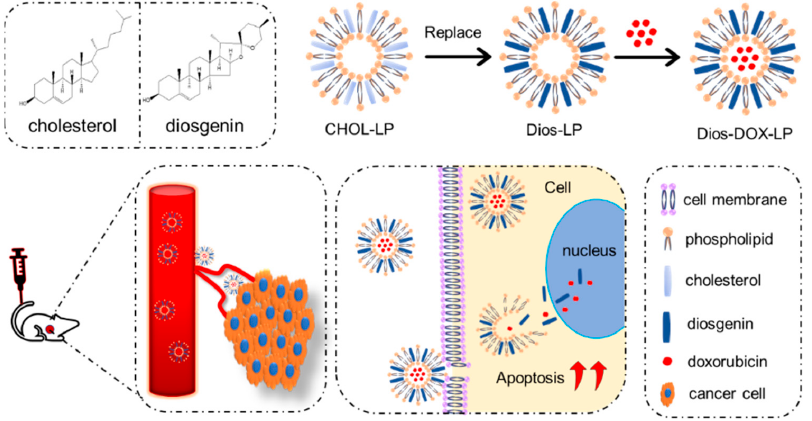
Figure 1. The design of a diosgenin-based liposome delivery system combined with doxorubicin for liver cancer therapy.